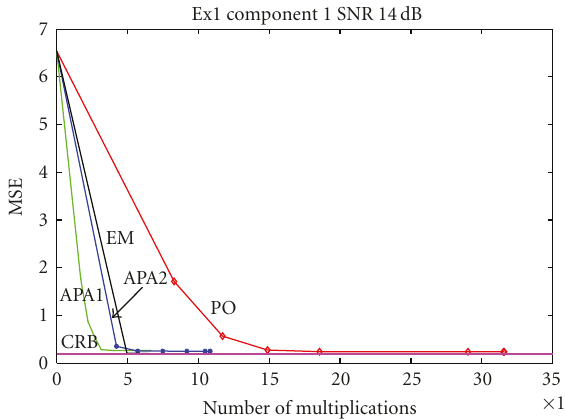
Figure 9: Experimental MSE versus computation cost for Ex1 at 14dB (component 1).